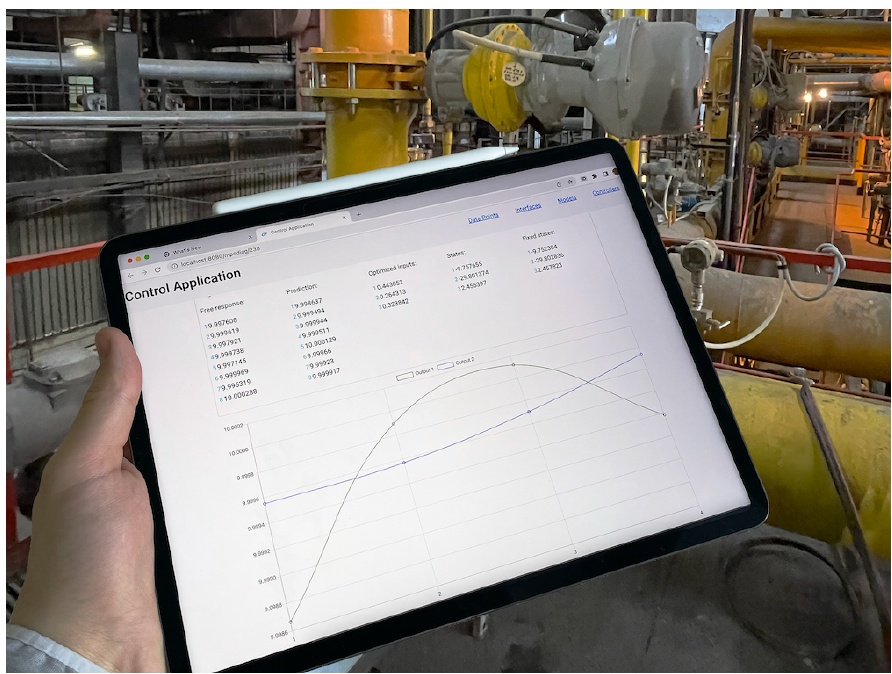
Figure 4. The User Interface of the developed MPC application as used on the factory